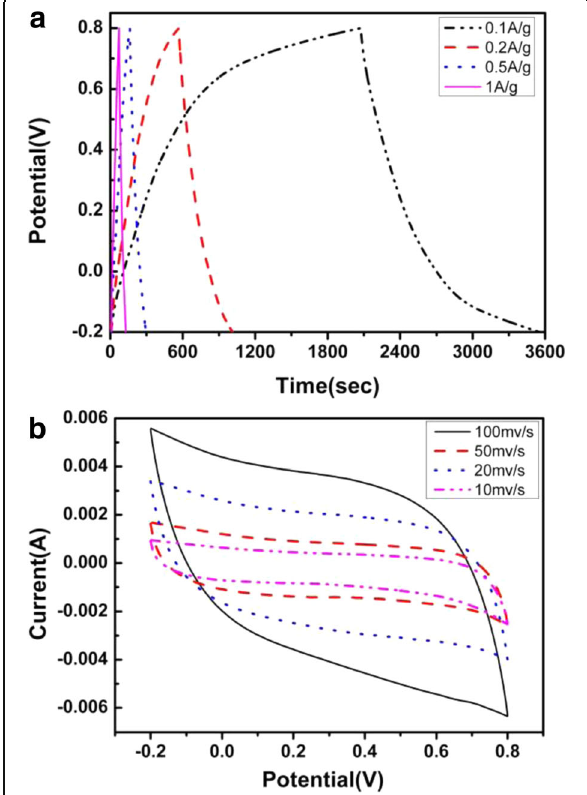
Fig. 6 Galvanostatic charge/discharge curves ( a ) and CV pattern ( b ) of the as-prepared film in 0.5 M Na 2 SO 4 (pH 6.0) (mass ratio of 50:1 and scan rate of 50